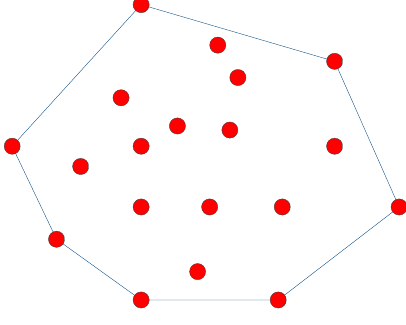
Figure 3. Schematic of a 2D convex hull.